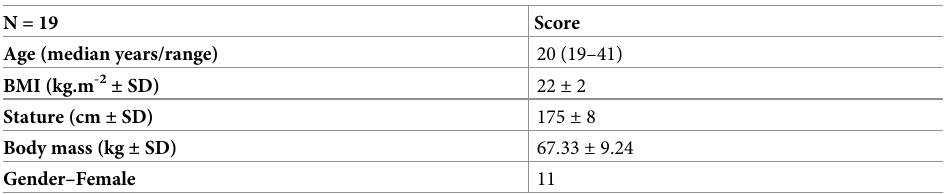
Table 1. Demographic